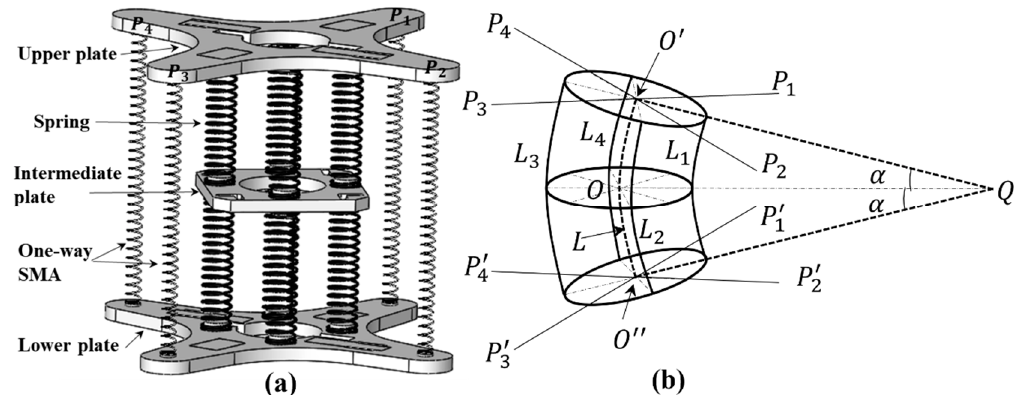
Figure 6. Three-dimensional simplified model of the module. ( a ) 3D simplified solid model of the module. ( b ) Geometric model of module element in bending.